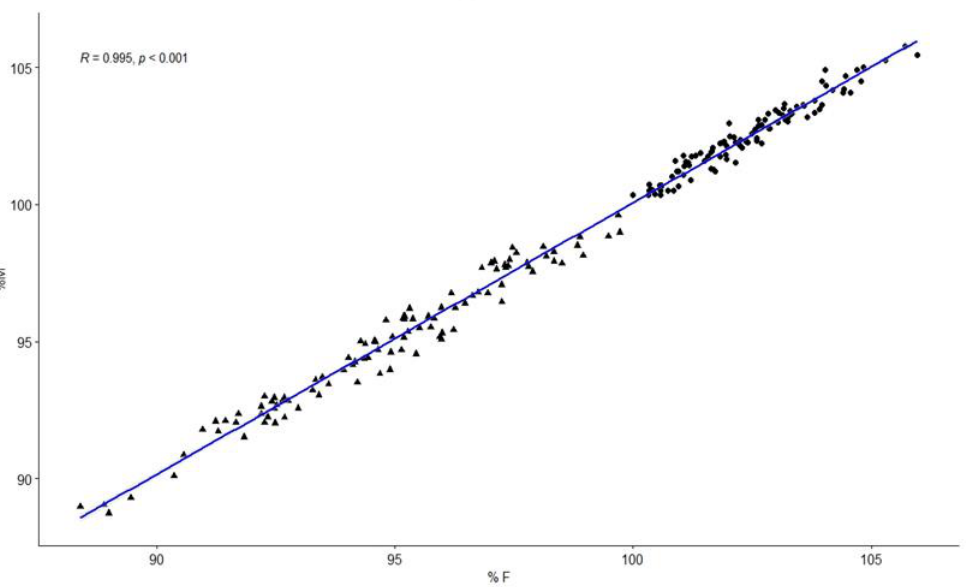
Figure 5. Correlation analysis between the values obtained in the intraoral frontal photograph and those obtained in the study models. The round points are the points of the control group, and the triangle points are the points of the pathology group.